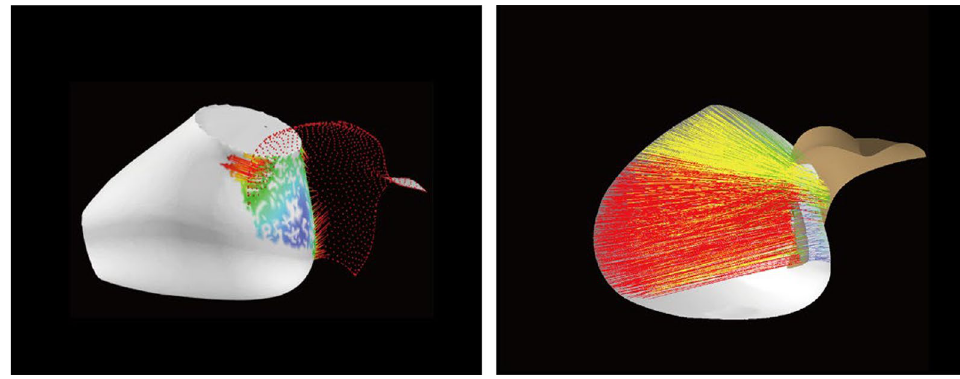
Figure 11. The visual effect between tragus and earphone by deviation analysis tool of CATIA (right) and deviation analysis algorithm (left).